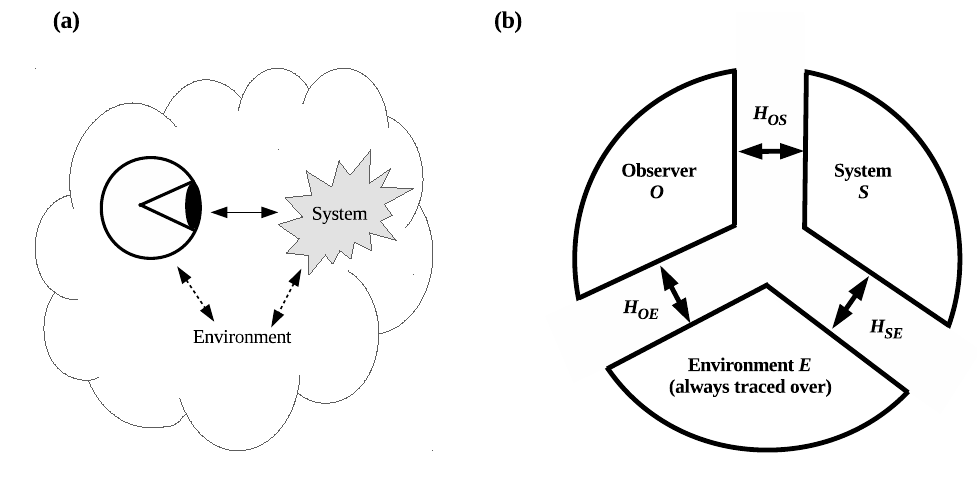
Figure 1. ( a ) The classical conception of observation, standardly carried over into quantum theory. The observer interacts with a system of interest; both are embedded in a surrounding environment. ( b ) Interactions between observer ( O ), system of interest ( S ) and environment ( E ) enabling environmental decoherence [1,2]. The Hamiltonian H OS transfers outcome information from S to O ; H SE and H OE decohere S and O respectively. Adapted from [66] Figure